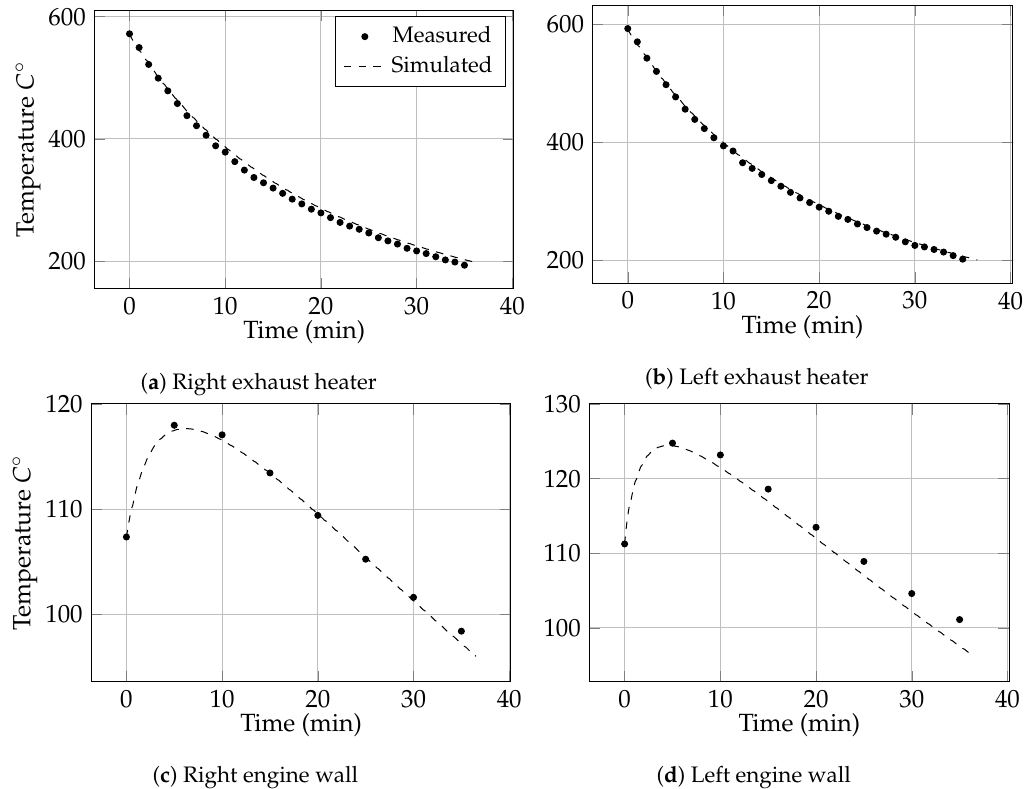
Figure 12. Comparison between the computed and experimentally measured average surface temperatures of the engine solids during